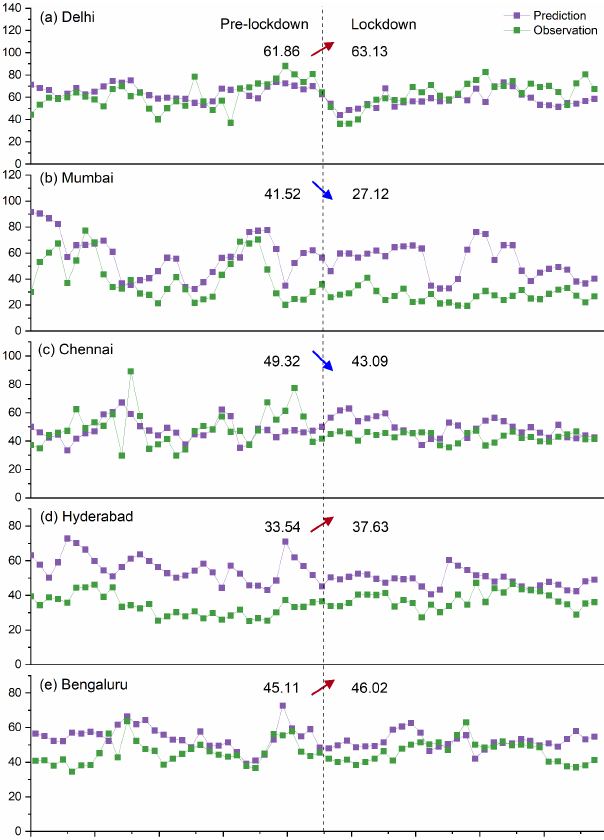
Figure 4. Predicted PM 10 (µgm − 3 ), PM 2 . 5 (µgm − 3 ), MDA8 O 3 (ppb), NO 2 (ppb), and SO 2 (ppb) before lockdown, during the lock- down and the changes between them in India. “Case 2 − Case 1” indicates (Case 2 − Case 1) / Case 1, reported as